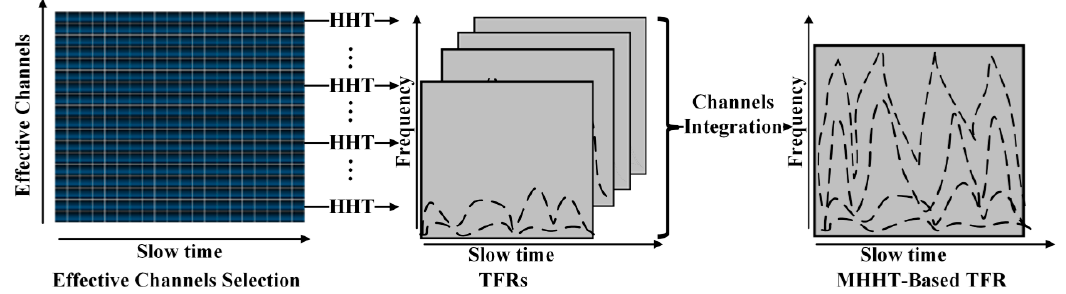
Figure 4. Process diagram of MHHT for 2D UWB radar signal.